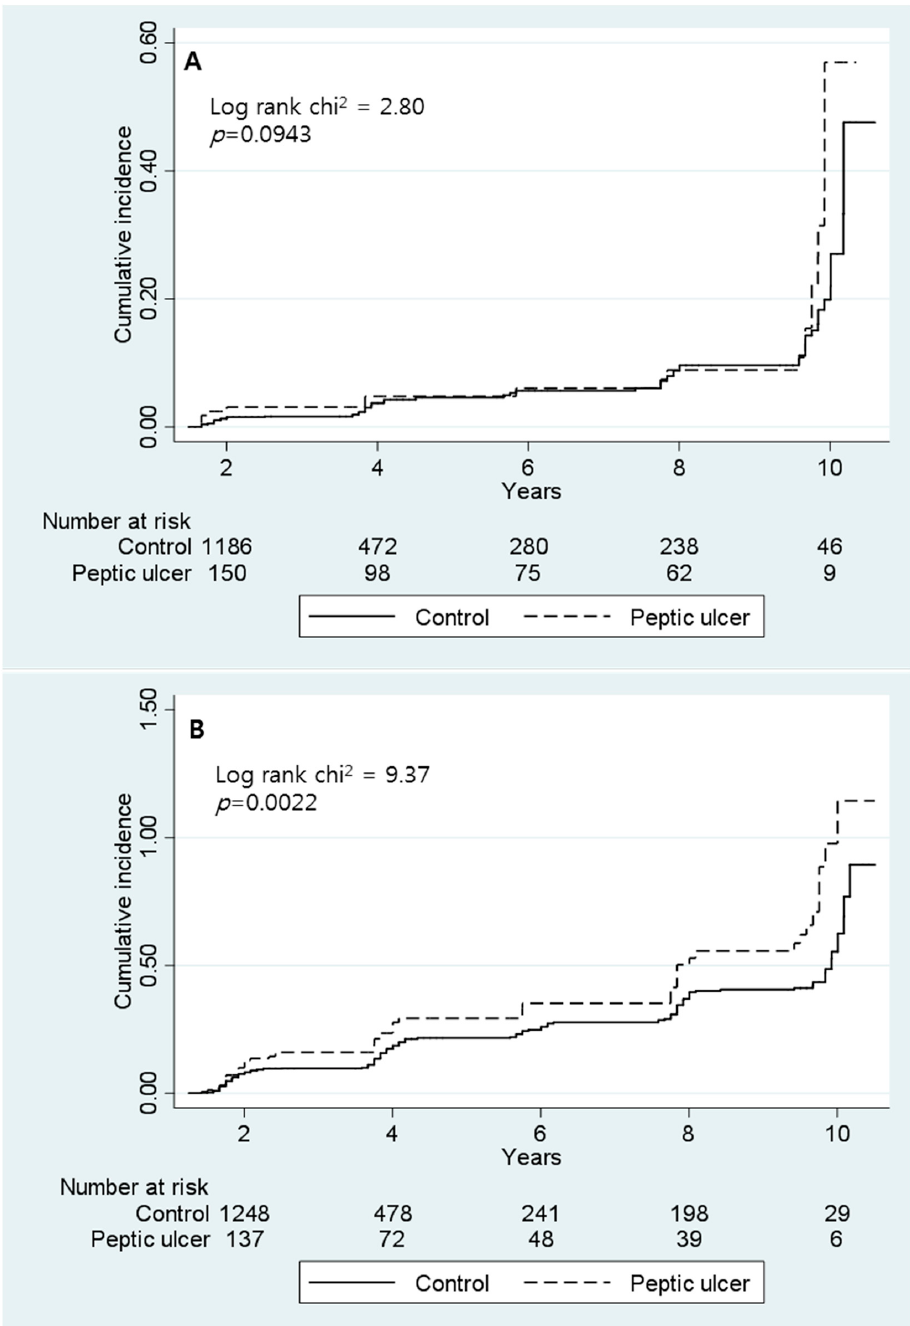
Figure 2. Cumulative incidence of osteoporosis in men ( A ) and women ( B ) with or without peptic ulcer disease.